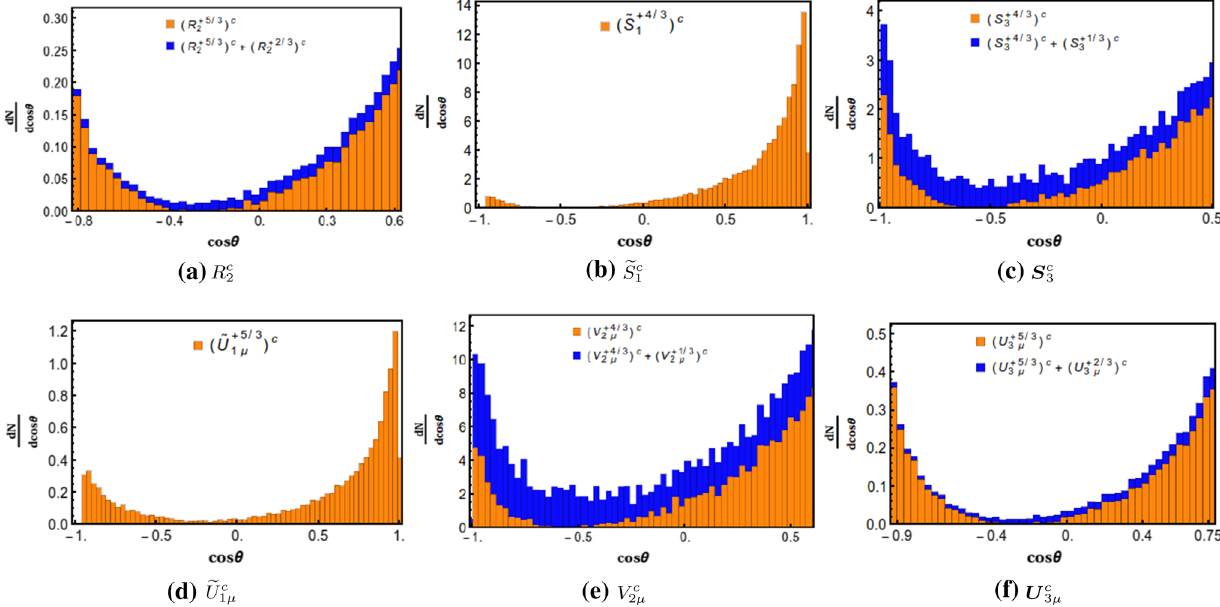
√ s = 2190 . 2 GeV and L int = 2000 fb − 1 . The sub-figure